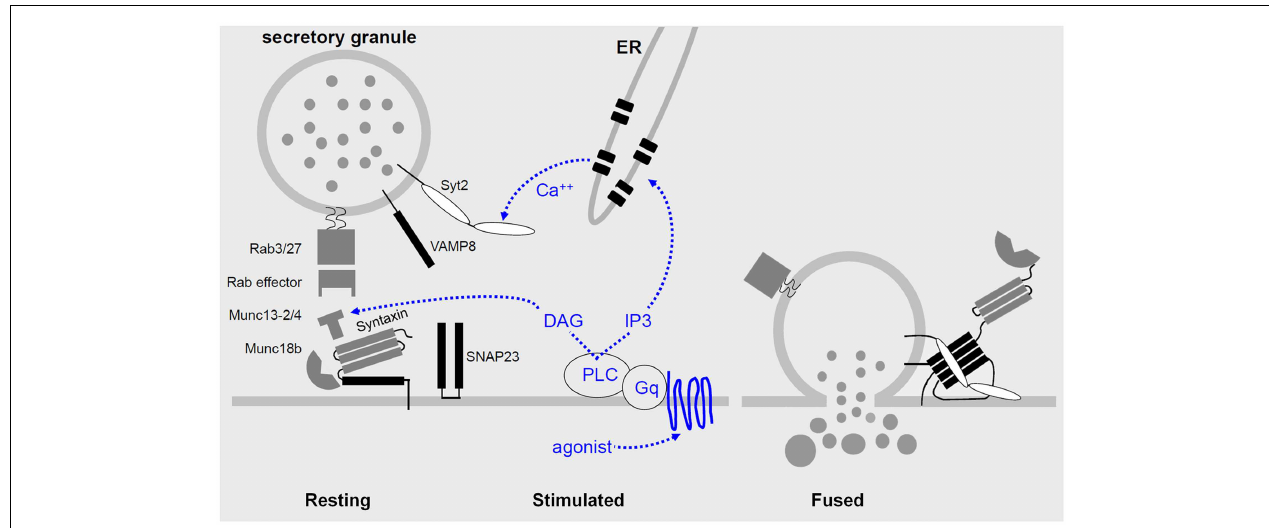
unknown high affinity calcium sensor likely functions in basal secretion rather than Syt2. Right – Activation of the regulatory Munc13 and Syt proteins leads to full coiling of the SNARE proteins (SNAP23,VAMP8, and an unknown Syntaxin, all shown in black) to induce fusion of the granule and plasma membranes.The interactions of the SNARE proteins take place on a scaffold provided by Munc18b. In other secretory cells that form the basis for this model, exocytic Syntaxins contain four hydrophobic coiled-coil domains that must be opened to initiate secretion (left panel), and during fusion the associated Munc18 protein remains associated only by an interaction at the Syntaxin N-terminus (right